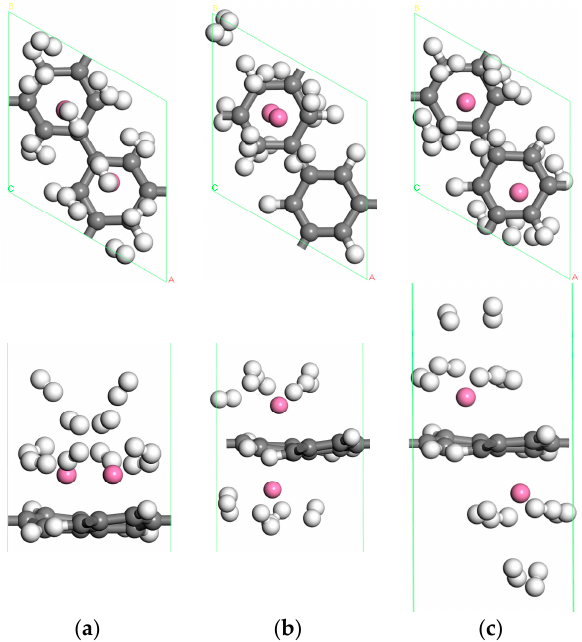
Figure 7. The optimized geometries for H 2 molecules adsorbed on Sc-decorated PG. ( a ) two Sc atoms decorated single-sided PG; ( b ) two Sc atoms decorated double-sided PG at the same hole; ( c ) two Sc atoms decorated double-sided PG at the adjacent hole.